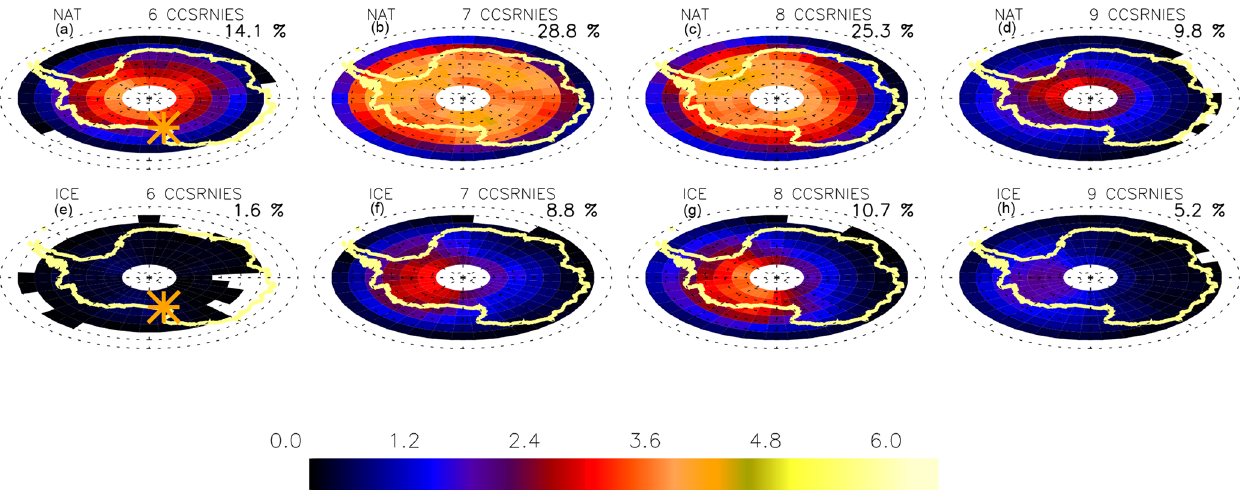
Figure 7. CCSRNIES PSCs vertical extent (in km) for NAT and ice, averaged over 5 years during the months of June, July, August and September (left to right). In the left column, the location of McMurdo is indicated with a yellow asterisk. The fraction of the overall air volume (between 12 and 30km height south of 60 ◦ S) occupied by different PSC classes for each month is reported in the top-right